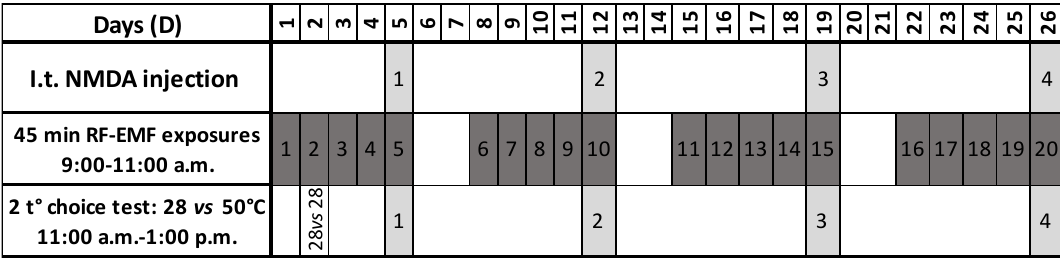
Figure 1. Rats underwent 20 radiofrequency electromagnetic field (RF-EMF) exposures (0, 1.5 or 6 W/kg) between 9:00 and 11:00 a.m. On day 2, side preference was measured in the test apparatus (28 °C versus 28 °C). The 5th, 10th, 15th and 20th RF-EMF exposures were performed immediately after the i.t. injections of N-methyl d-aspartate (NMDA) or saline, followed by the two-temperatures choice test (28 °C versus 50 °C, between 11:00 a.m. and 1:00 p.m.).